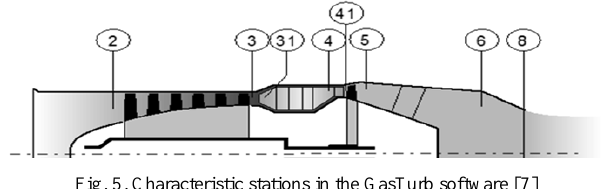
Fig. 5. Characteristic stations in the GasTurb software [7]